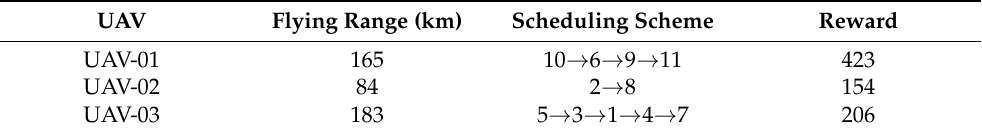
Figure 11. Task re-scheduling schemes with the pop-up obstacle based on replacement contract. ( a ) UAV-01; ( b ) UAV-02; ( c ) UAV-03. Table 11. Task Rescheduling Schemes based on Buy-sell Contract to Deal with Pop-up Obstacles.